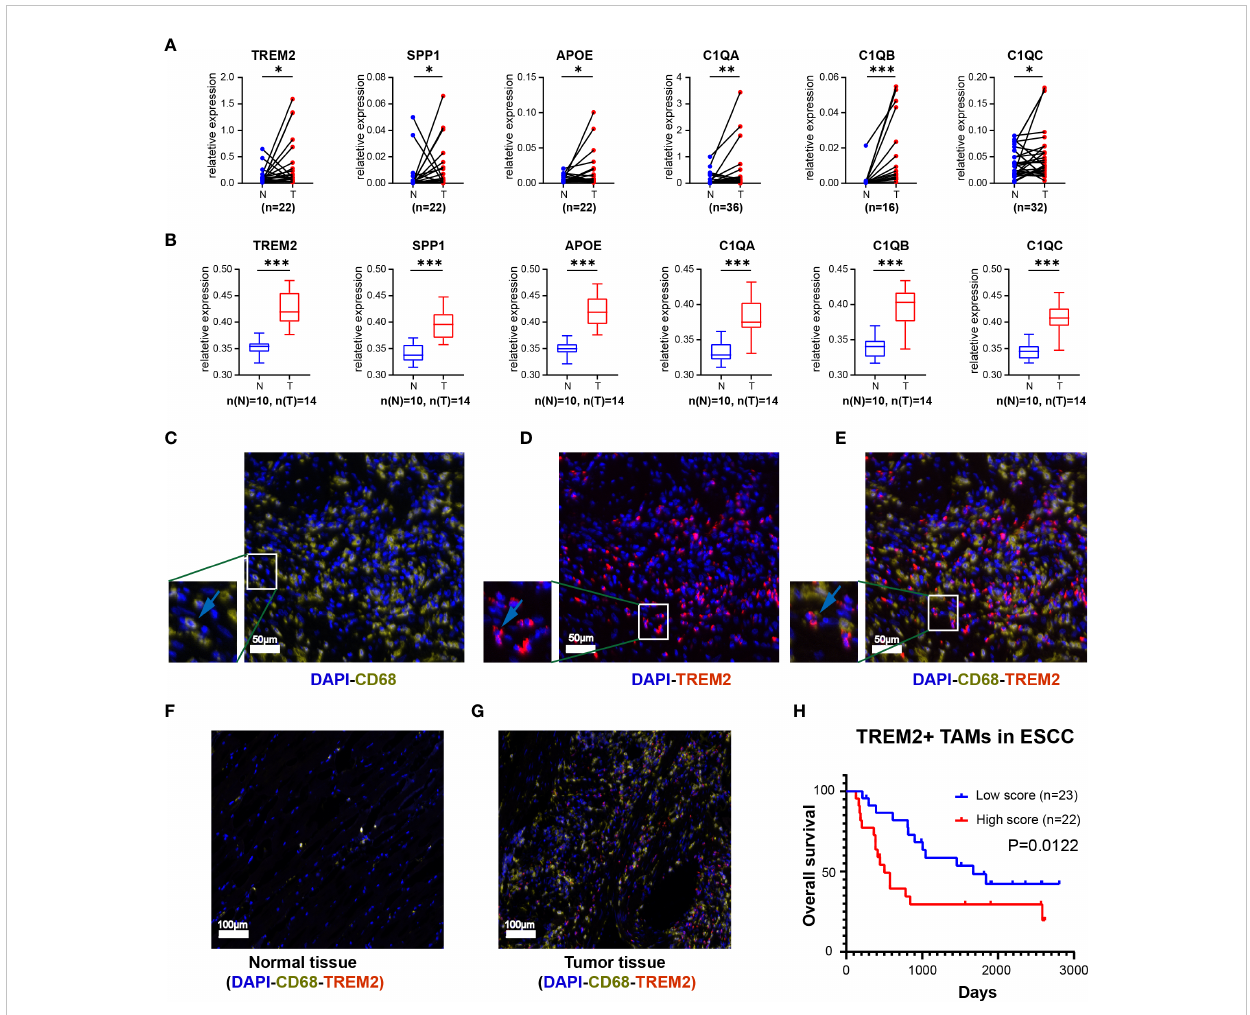
FIGURE 3 The expression level of top 6 genes of Novel TAM subpopulation between ESCC tissue and normal tissue. (A) Expression levels of TREM2 , SPP1 , APOE , C1QA , C1QB , and C1QC in ESCC tissues and corresponding normal tissues using qRT-PCR. (B) Protein expression levels of TREM2, SPP1, APOE, C1QA, C1QB, and C1QC in the plasma of ESCC patients and healthy controls. (C-E) Three-color multispectral and separated individual spectral images of multiplexed immuno fl uorescence staining with DAPI (blue), CD68 (yellow), and TREM2 (red). (F) TREM2 + TAMs in normal esophageal tissue. (G) TREM2 + TAMs in tumor esophageal tissue. (H) ESCC having high levels of TREM2 + TAMs had the worst OS (P = 0.0122). *, P <0.05; **, P < 0.01; ***, P <